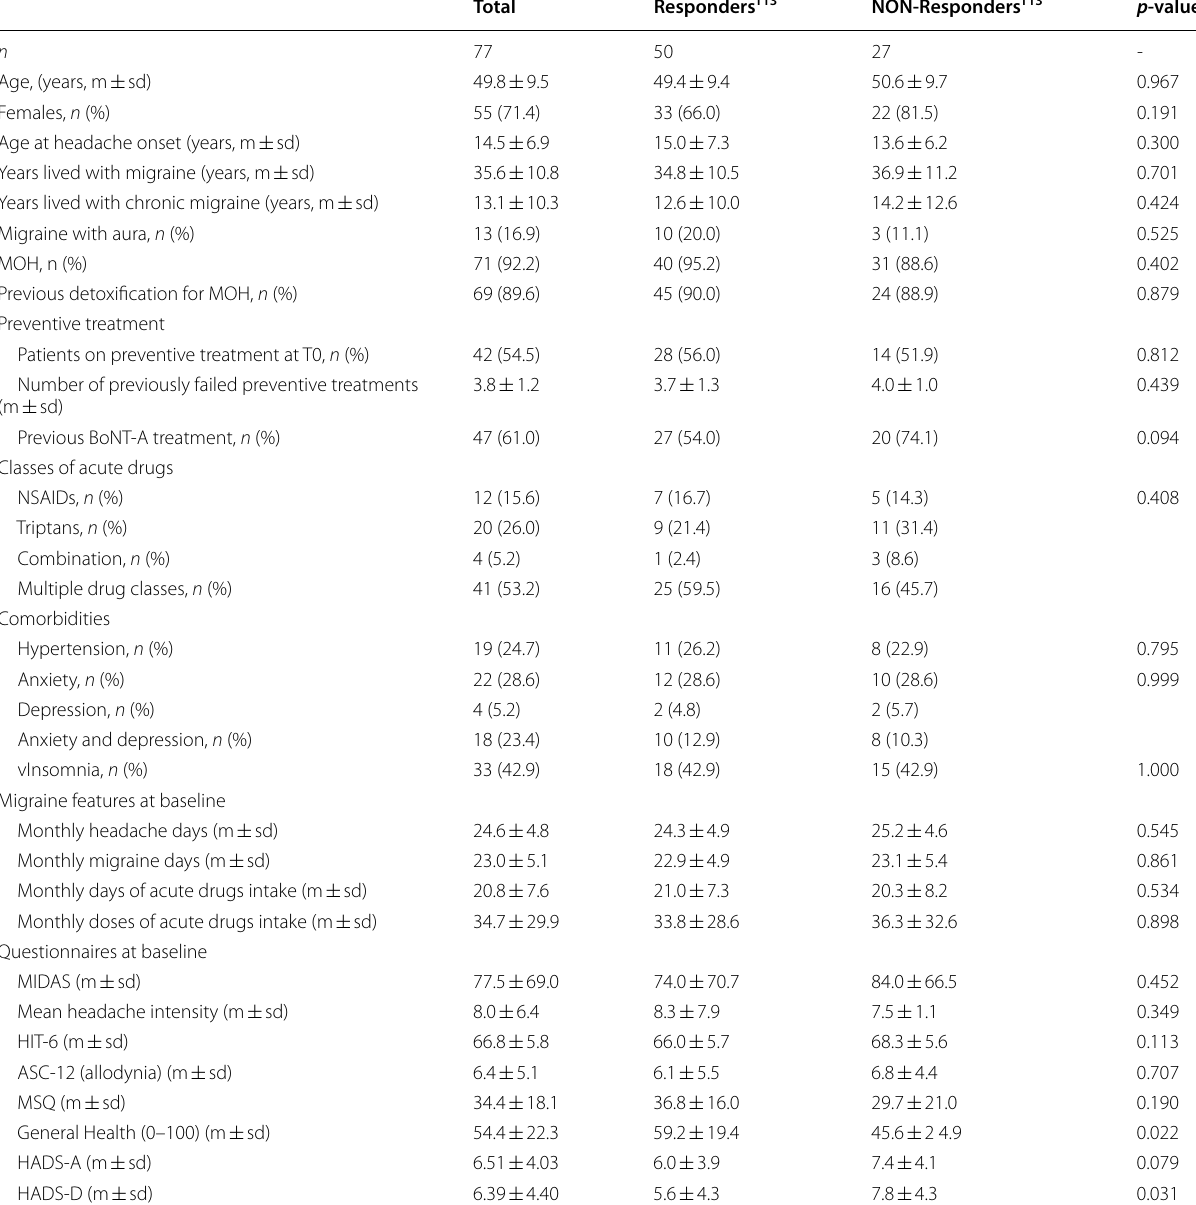
Table 2 Clinical and demographic features of Responders T13 and NON-Responders